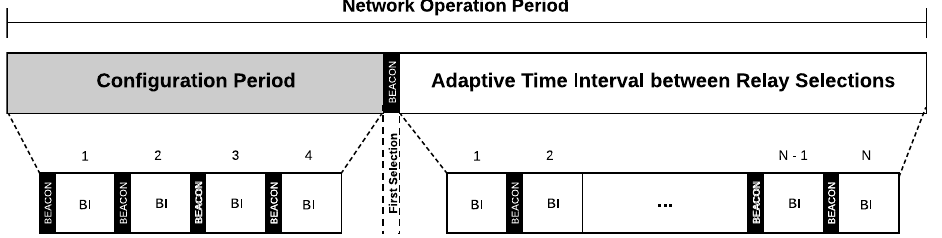
Figure 9. Operation of the adaptive relay selection